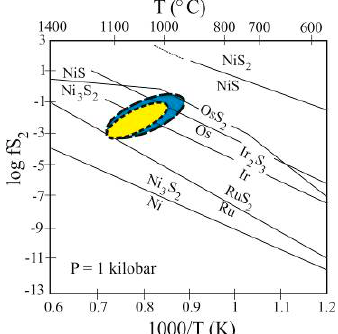
Figure 16. Metal-sulfide equilibrium curves for Ru, Os, Ir, and Ni as function of sulfur fugacity, expressed as log fS 2 and temperature. Yellow and blue fields show the conditions prevailing in mantle-hosted chromitites from ophiolites of the Urals. Yellow field = present work, blue field = [9,22–24].